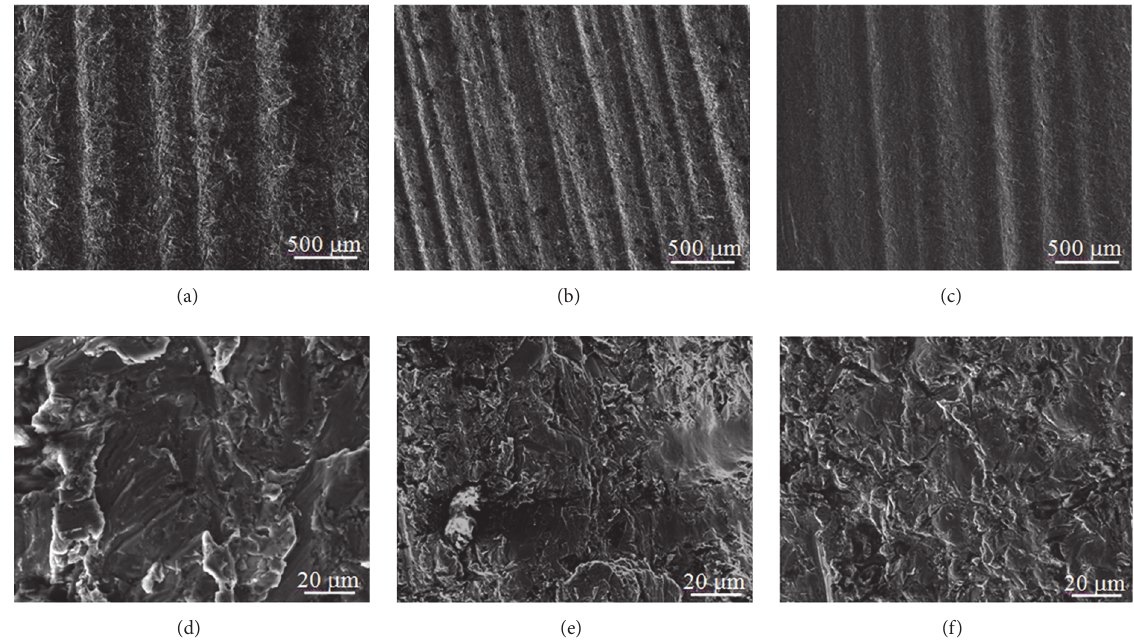
Figure 7: SEM morphology of the worn surface of the specimen after different heat treatments: (a) and (d) quenching, (b) and (e) once tempering, and (c) and (f) twice